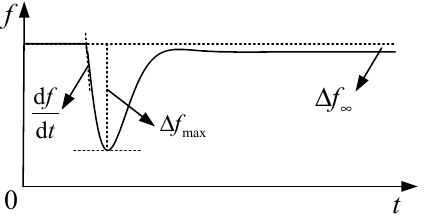
Figure 6. The change process of the system frequency when the load suddenly increases.